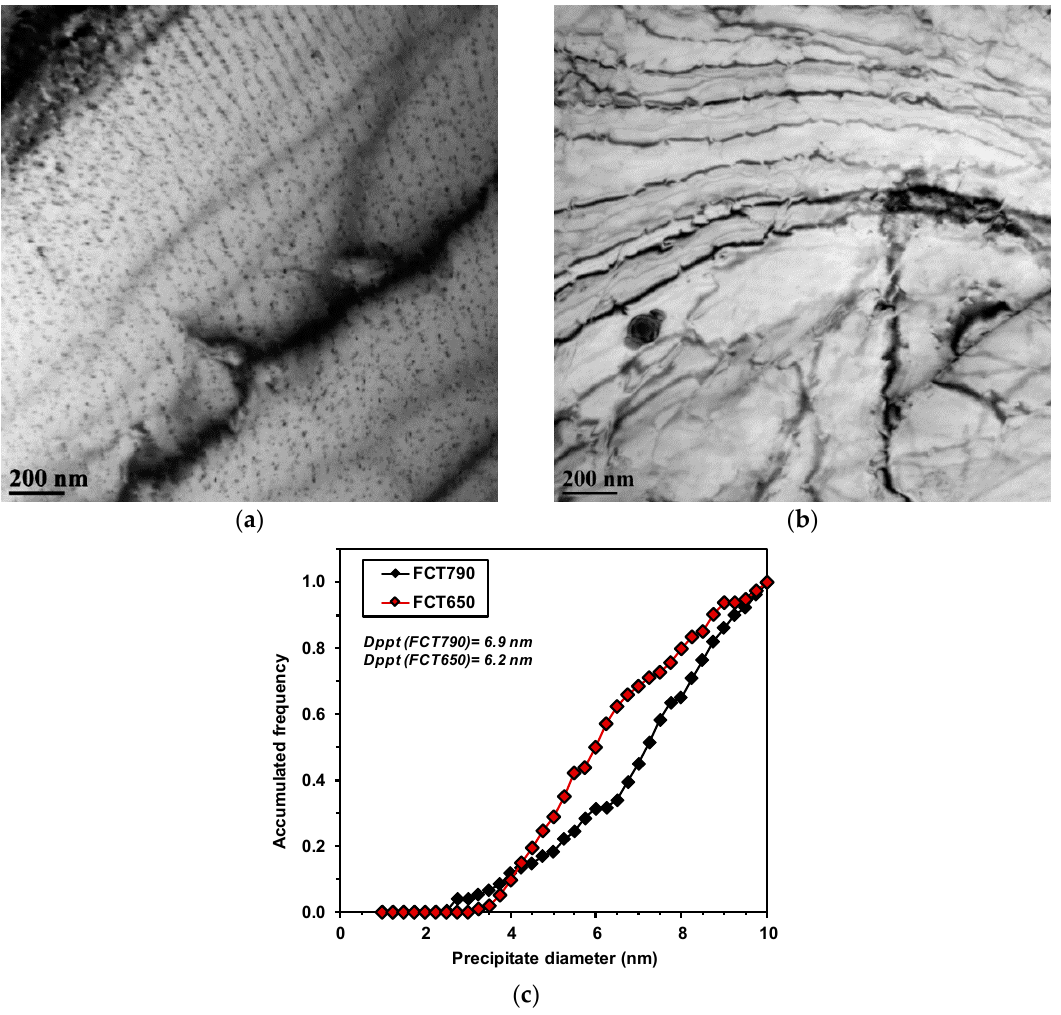
Figure 13. Thin foil TEM micrographs for the samples without induction treatment: ( a ) FCT790 and ( b ) FCT650. ( c ) Influence of the Fast Cooling Temperature on the precipitate size distribution (representing accumulated frequency).